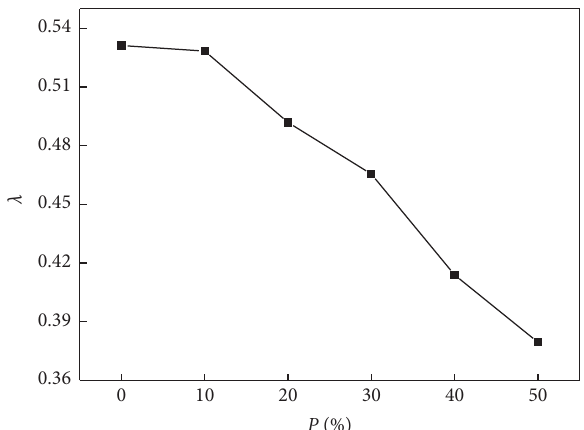
Figure 10: Ductility variation of concrete with the change of fy